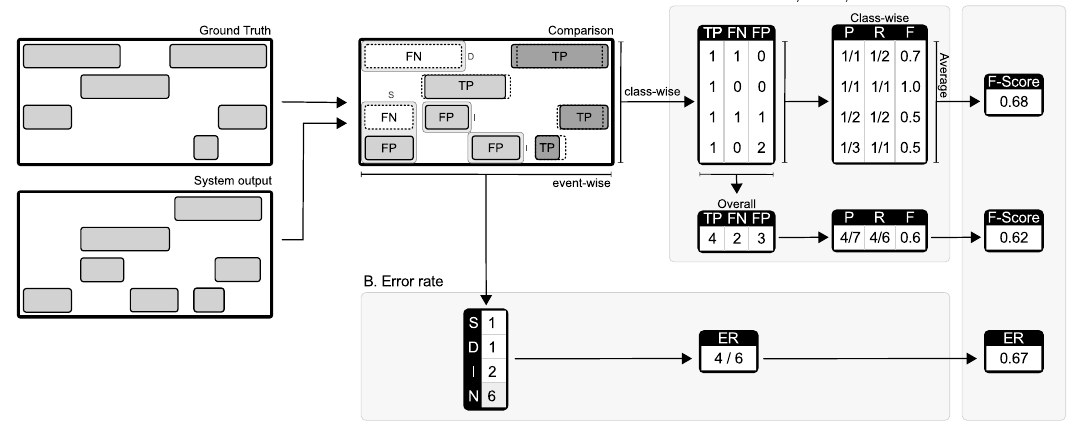
Figure 5. Calculation of event-based